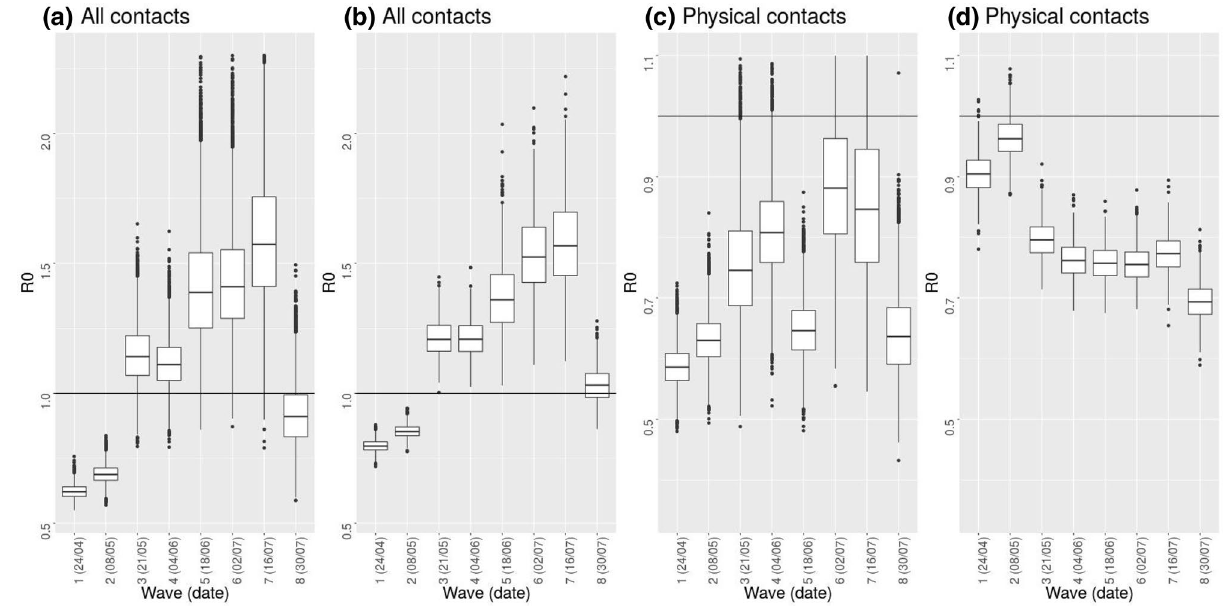
Figure 4. Reproduction number. ( a , b ): Reproduction number considering all contacts, without imputation ( a ) and with imputation of contacts for children (i.e. individuals <18y) ( b ).( c , d ): Reproduction number considering physical contacts, without imputation ( c ) and with imputation of contacts for children ( d ). All values are obtained starting from a normally distributed R 0 ( mean = 3.344 , sd = 0.028 ) and the ratio of R 0 computed with respect to the 2010 survey data. The horizontal line marks a reproduction number of